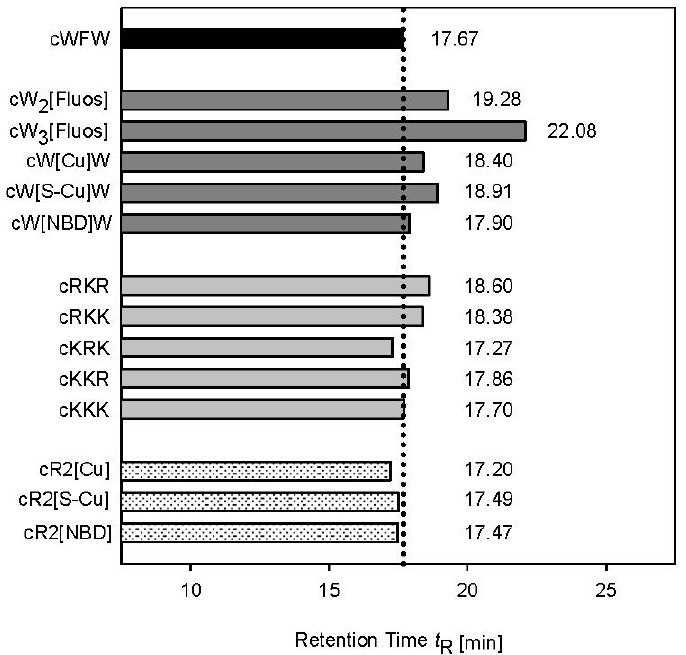
of the cyclic hexapeptides. The influence of fluorescent labels Figure 2. Retention times t R (dark grey), lysine substitution (light grey) and double modifications (shaded) on interaction with the hydrophobic column is shown compared to the parent peptide cWFW